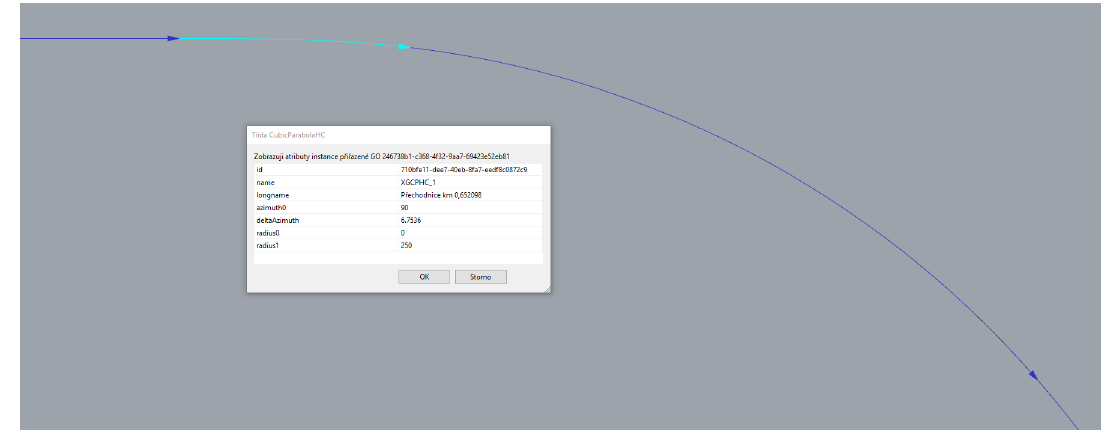
Figure 3. Horizontal curves rendered on the basis of the analytical description of the track geometry